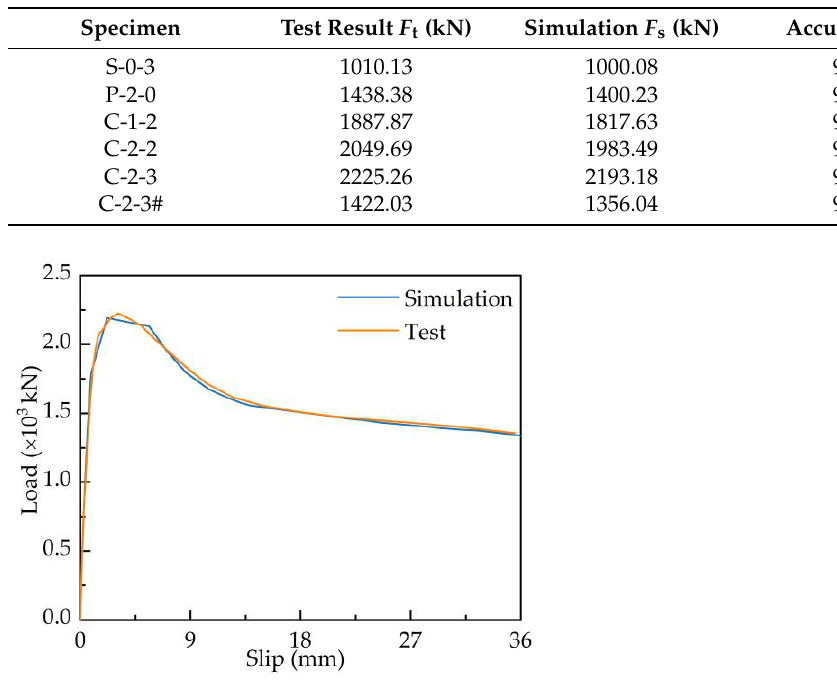
Figure 18. Load – slip curve comparison of specimen C-2-3. Figure 18. Load–slip curve comparison of specimen C-2-3.